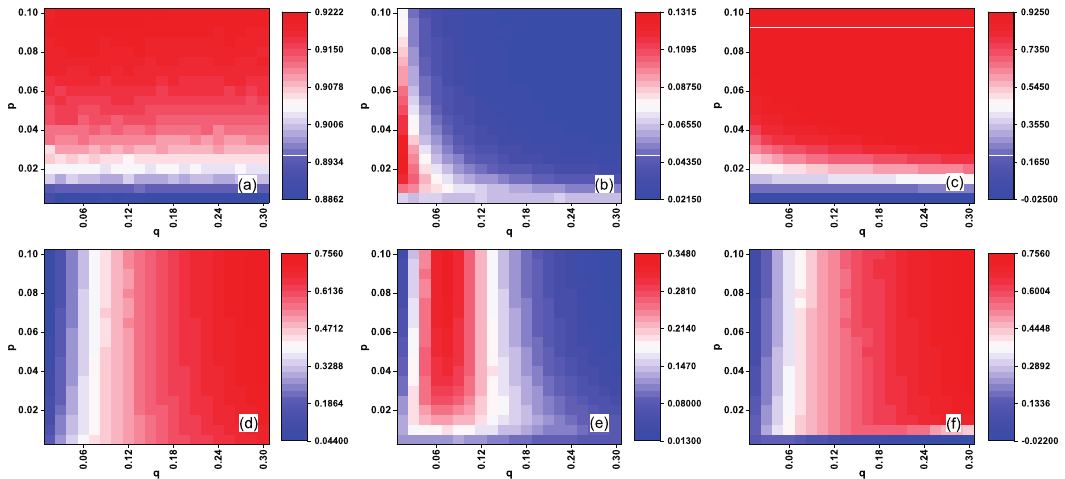
Fig 5. (Color online) The effectiveness of the EigenRank algorithm under malicious rating attack for the Netflix data set: (a) the AUC values AUC ; (b-c) Δ AUC , the comparison of AUC between EigenRank algorithm and IBeta method (b), Vote e e e Aggregation method (c); (d) the recall R c ( L ); (e-f) Δ R c ( L ), the comparison of recall between EigenRank algorithm and IBeta method (e), Vote Aggregation method (f). The parameters q and p denote the ratio and the activity of spammers, respectively and L = q | U |. q ranges from 0.015 to 0.3 in increments of 0.015 and p ranges from 0.005 to 0.1 in increments of 0.005. It can be seen that and R ( L ) of the EigenRank algorithm are larger than their counterparts in the IBeta method and Vote Aggregation both the AUC e c method for different ( p , q ).